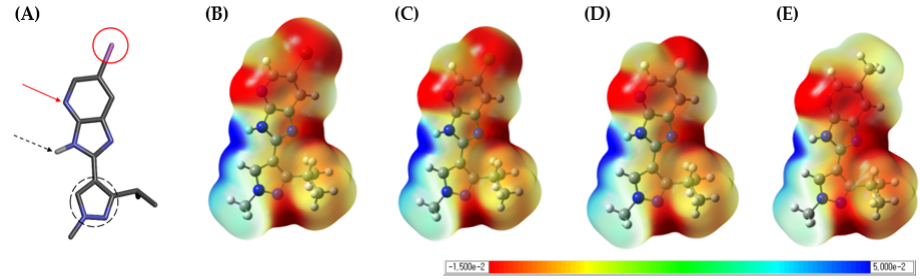
Figure 6. Compound 3D structure and the 3D plots of MEP surface. ( A ) Pink atom is indicated by a red circle as an atomic substitution part. The N atom of the pyridine on the scaffold is indicated by a red arrow. The NH atom of imidazole in the scaffold is indicated by a black dotted arrow, and the pyrazole is indicated by a black dotted circle. ( B ) Compound 1, ( C ) compound 2, ( D ) compound 3, and ( E ) compound 4 computed at the DFT/B3LYP/6-311G++ (3df) level of theory (0.004 a.u.).